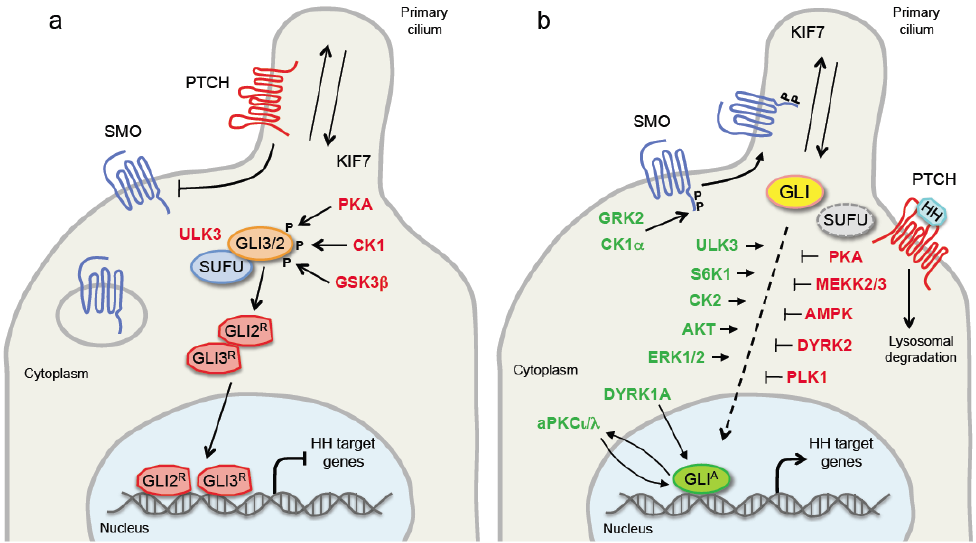
Figure 1. Overview of Hedgehog pathway in absence ( a ) and in presence ( b ) of HH ligand. Schematic diagram of the basic components of the HH signaling (filled circles) and protein kinases that act as positive (green) or negative (red) regulators. GLI2 and GLI3 move within the PC together with KIF7, a member of the kinesin family of anterograde motor proteins. See main text for details. Abbreviations: PTCH1, Patched 1; SMO, Smoothened; SUFU, Suppressor of Fused; HH, Hedgehog; KIF7, kinesin family member 7; CK1, caseine kinase 1; CK2, casein kinase 2; GSK3 β , glycogen synthase kinase 3 β ; PKA, protein kinase A; ULK3, Unc-51 like kinase 3; GRK2, G-protein coupled receptor kinase 2; S6K1, ribosomal protein S6 kinase 1; AKT, protein kinase B; ERK1 / 2, extracellular signal-regulated kinases 1 / 2; DYRK, dual specificity tyrosine-phosphorylation-regulated kinase; aPKC ι / λ , atypical protein